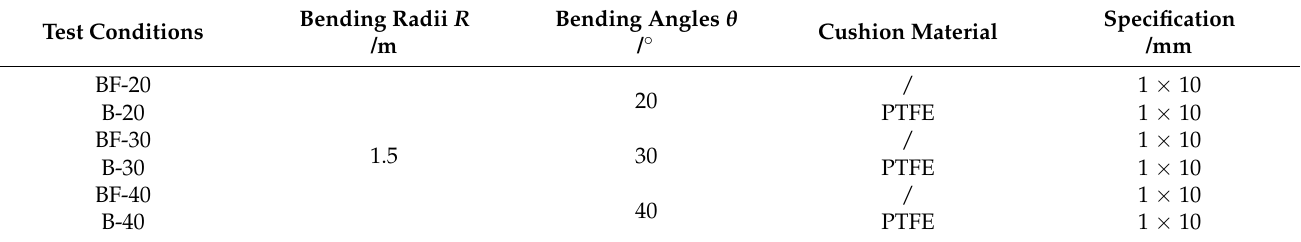
Figure 8. Test part with buffer material. Table 3. Bending test conditions of CFRP tendons.